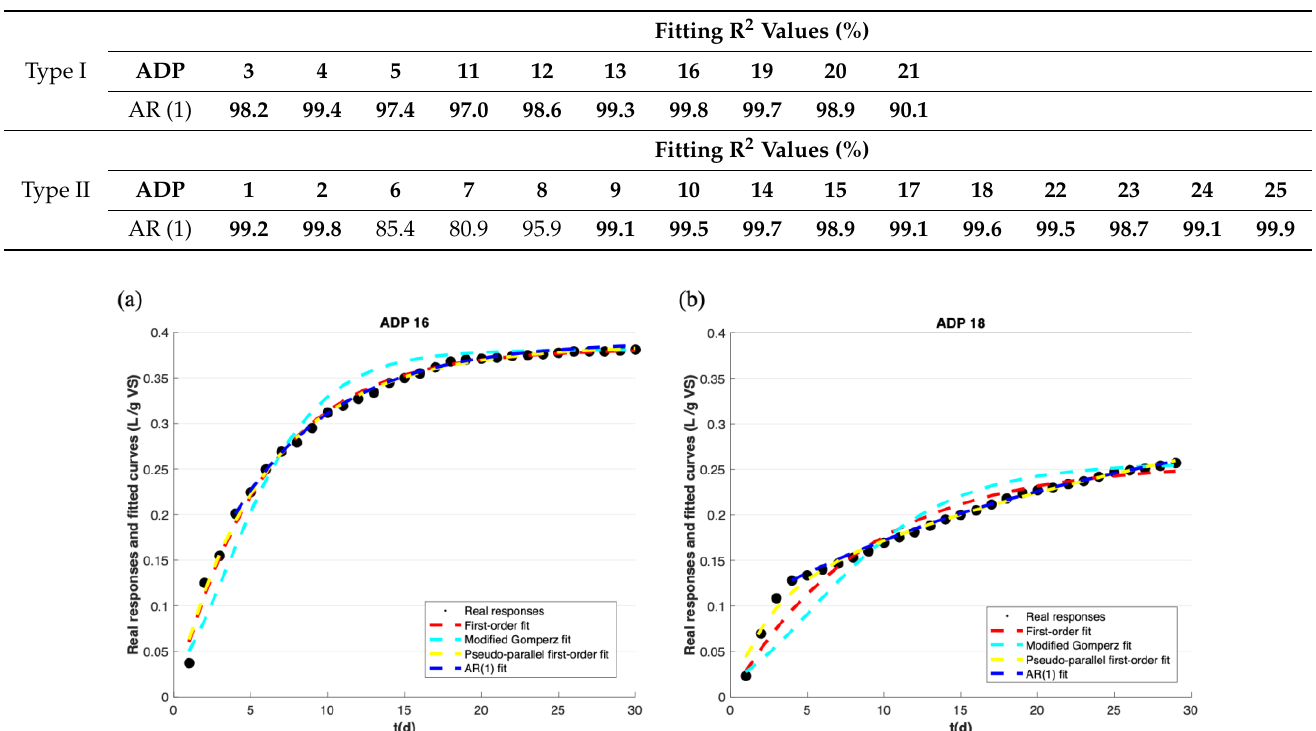
Table 5. R 2 values of the fits of the AR (1) model to the Type I and Type II RBP test biogas-production time series from day 4 (R 2 values larger than 97% are in bold).